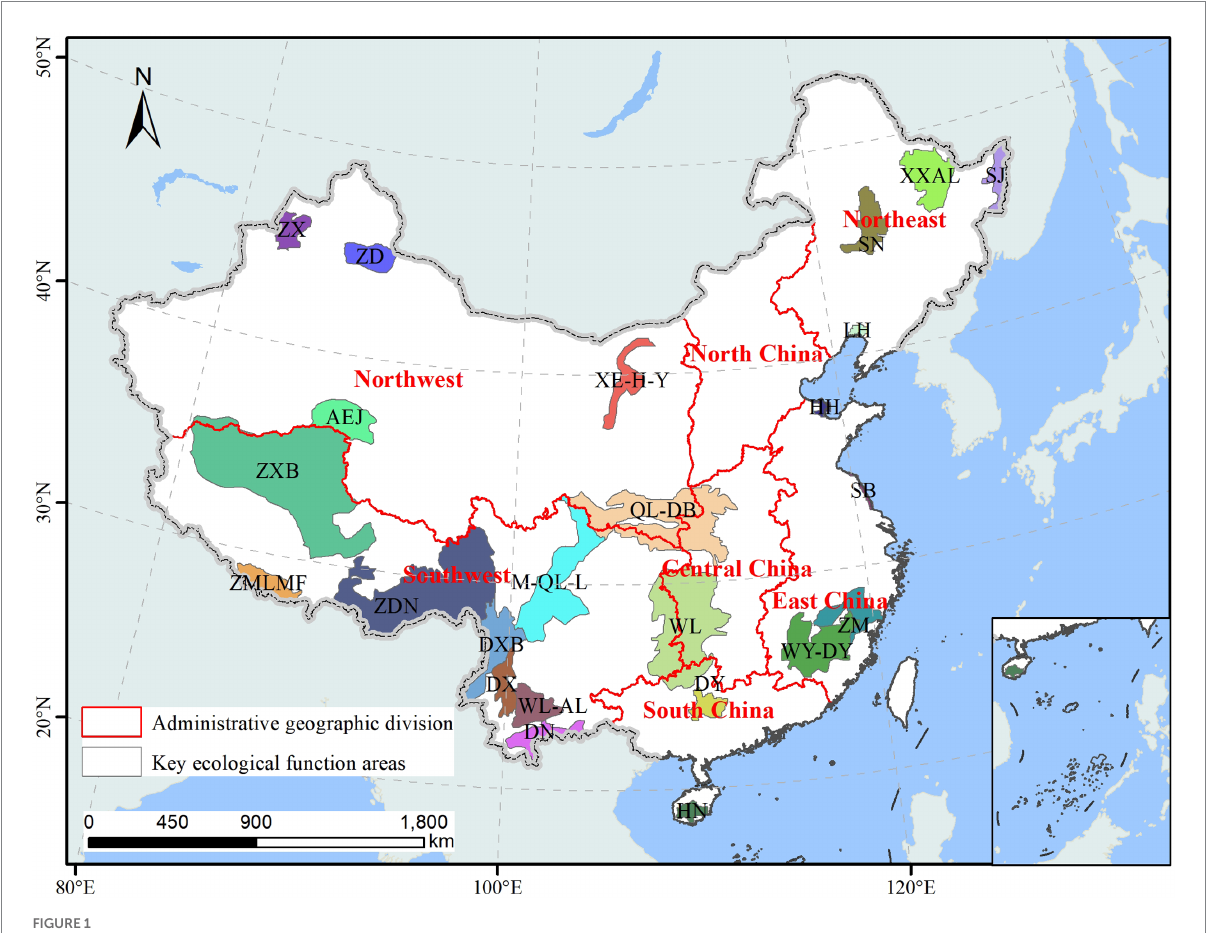
FIGURE 1 Distribution of KEFAs for biodiversity conservation in